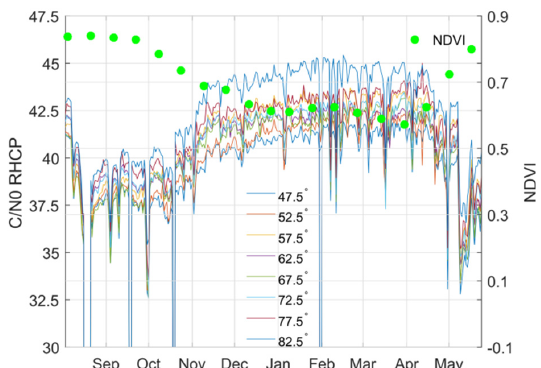
Figure 12. Evolution of normalized difference vegetation index (NDVI) and RHCP C/N 0 .